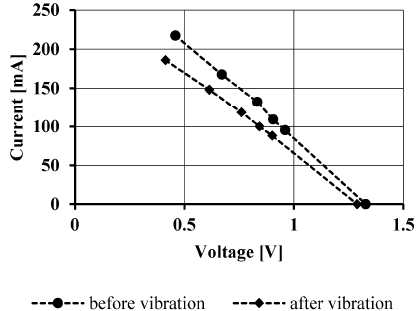
Figure 11. Comparison of V - I -characteristics of the big bulk device between before and after horizontal vibrations.